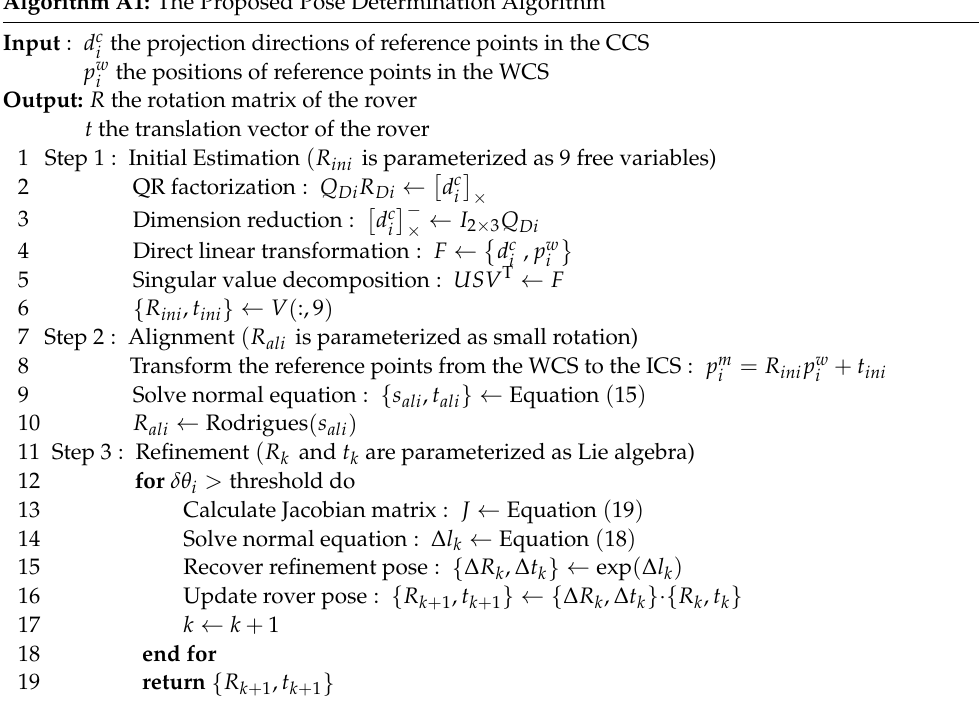
Algorithm A1: The Proposed Pose Determination